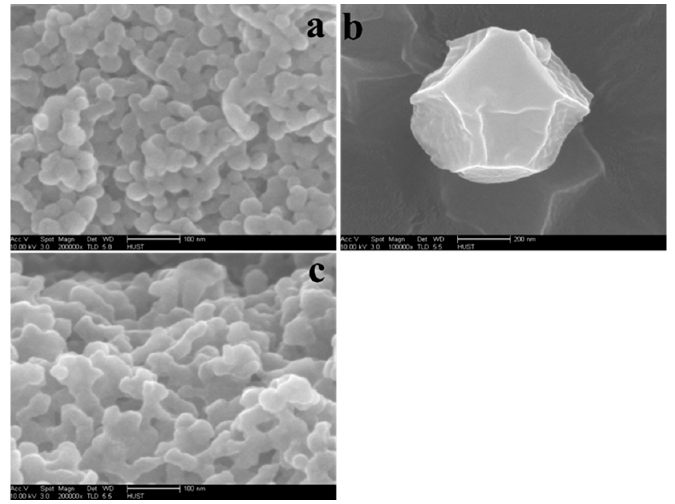
Figure 3. SEM images: ( a ) hierarchical ZIF-8; ( b ) hexahedral ZIF-8; ( c ) BCL-ZIF-8.